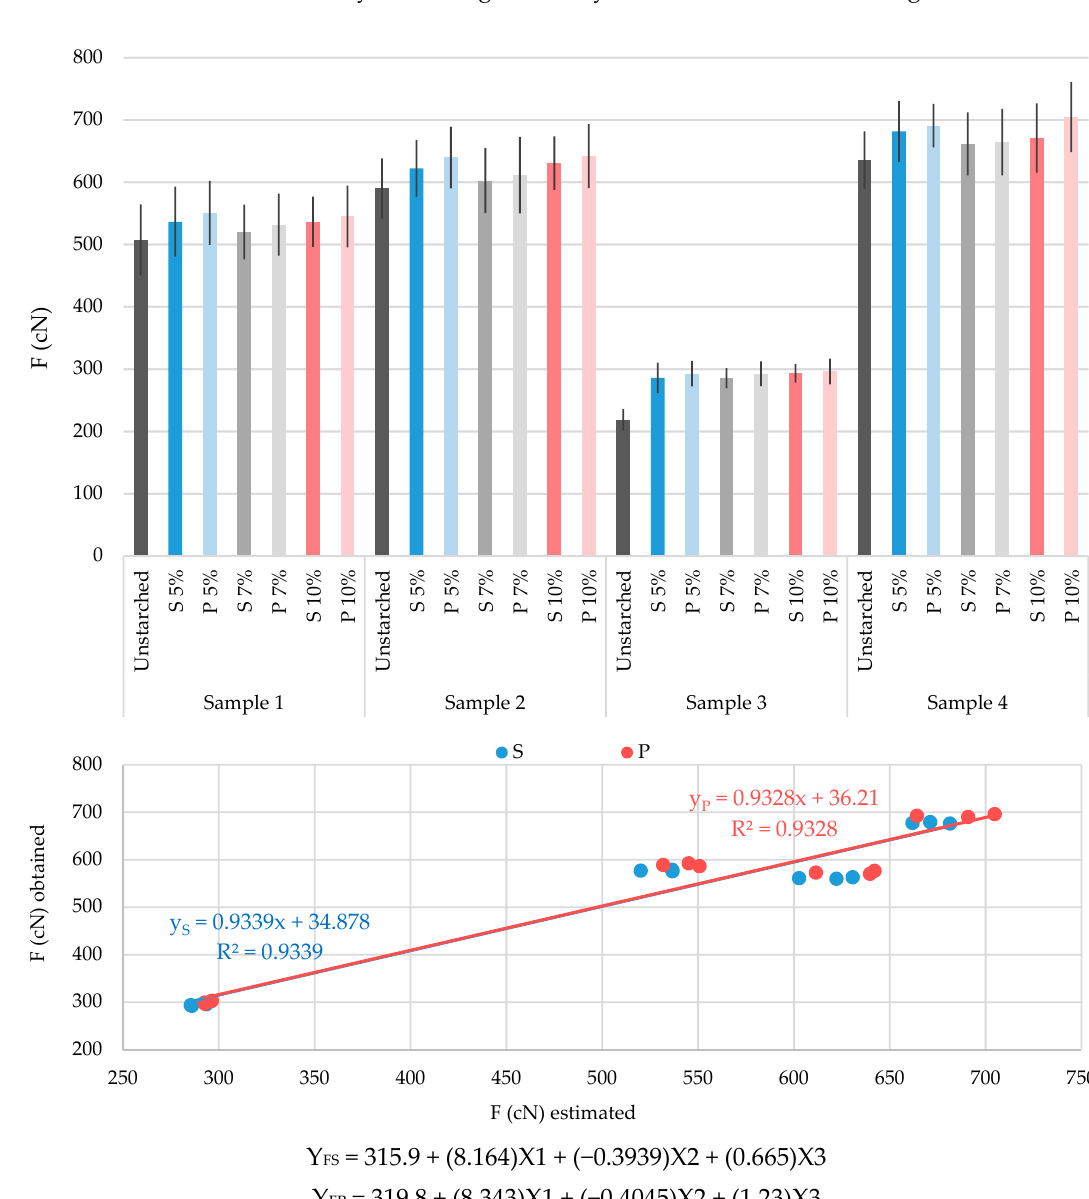
Figure 2. Diagram of breaking forces (F) of tested yarns: unstarched yarn and yarn starched by standard process (S) and by prewetting process (P), with 5%, 7% and 10% starch mass concentration.